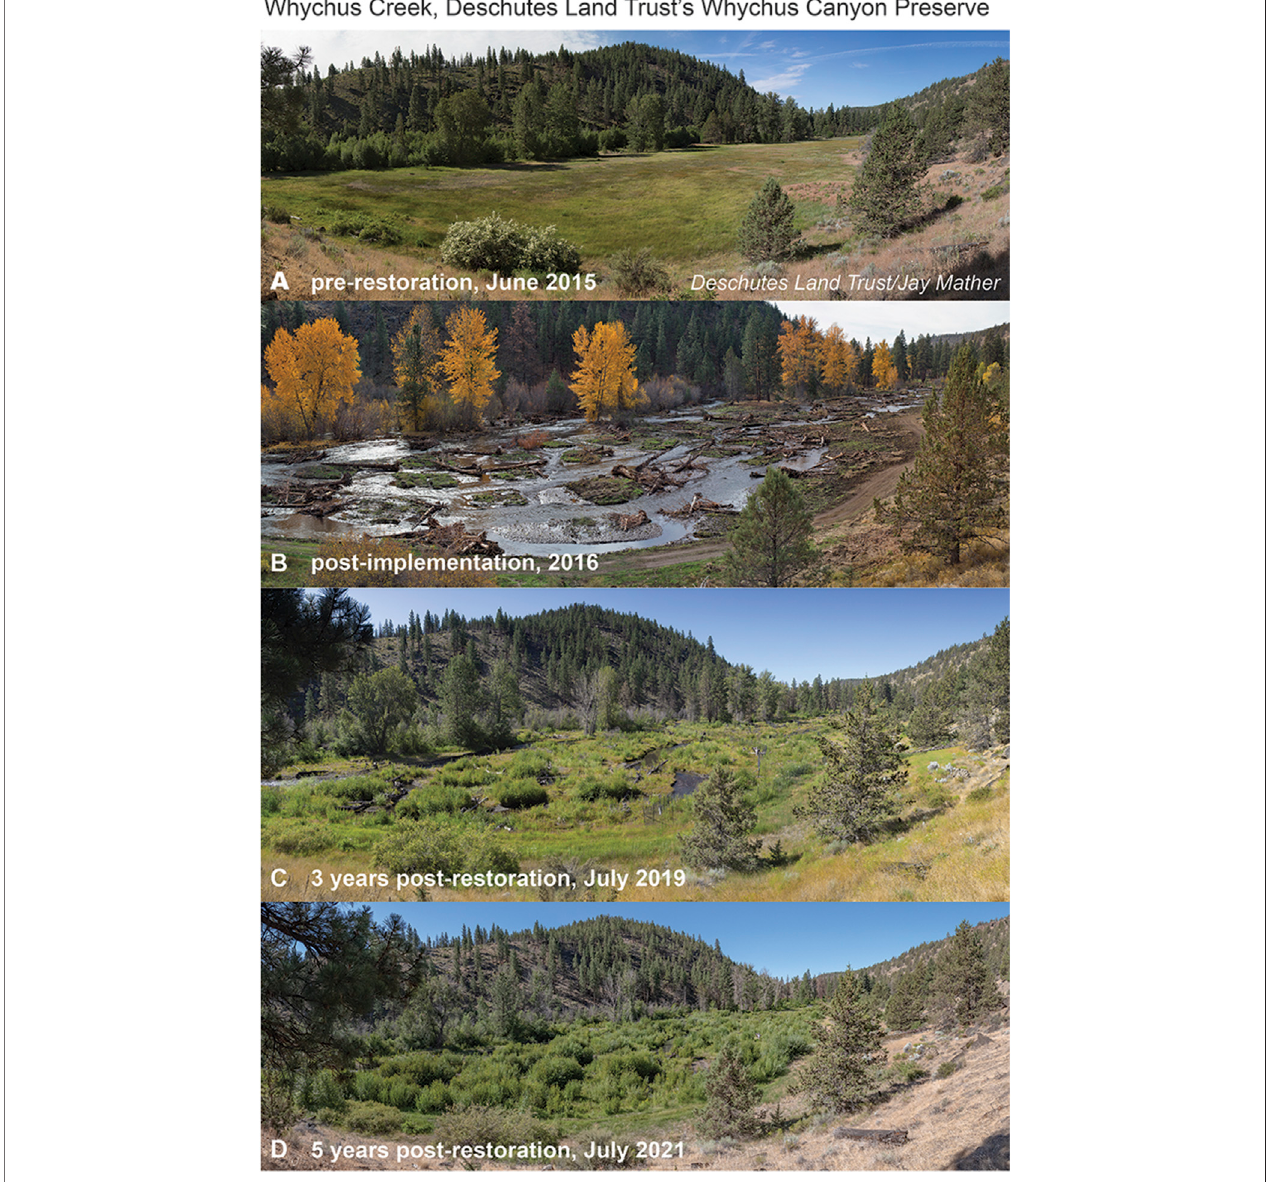
FIGURE 1 | At Whychus Creek, at the Whychus Canyon Preserve, restoration to a stage 0 condition was implemented and documented with photos of: (A) pre- restoration condition; (B) immediately post implementation condition; (C) 3 years post restoration, and; (D) 5 years post restoration.